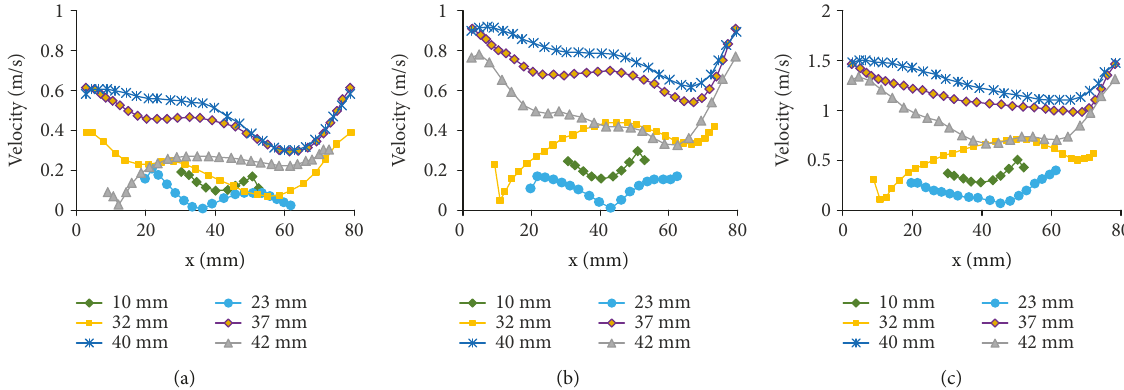
Figure 9: Velocity distribution of the polymer solution with a molecular weight of 1.6 × 10 6 dalton at 50m 3 /d when fl owing through the partially pressured injection tool with 18 slots.